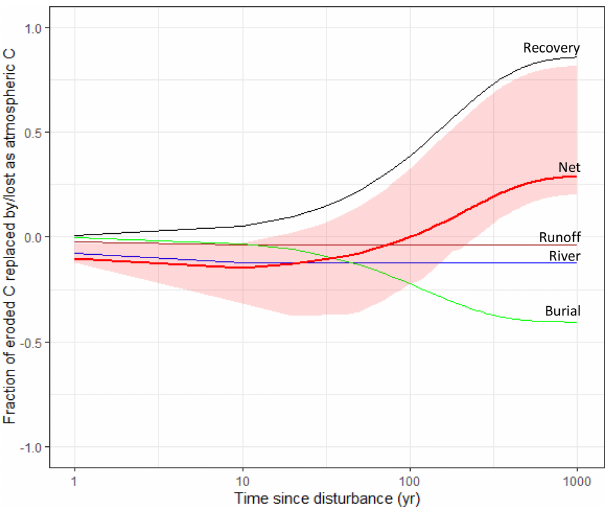
Figure 4. Framework to represent fraction gain/loss relative to mobilized soil OC for the different components of the geomor- phic cascade. The example shown here (full lines) uses the best estimates of model parameters described in the text and given in Table 2 (i.e., α runoff = 0.04, τ runoff = 1, α river = 0.5, τ river = 1, α burial = 0.54, τ burial = 0.008, α recovery = 0.86, τ recovery = 0.006). The red shaded area represents the uncertainty associated with the model parameters for the net overall effect (see